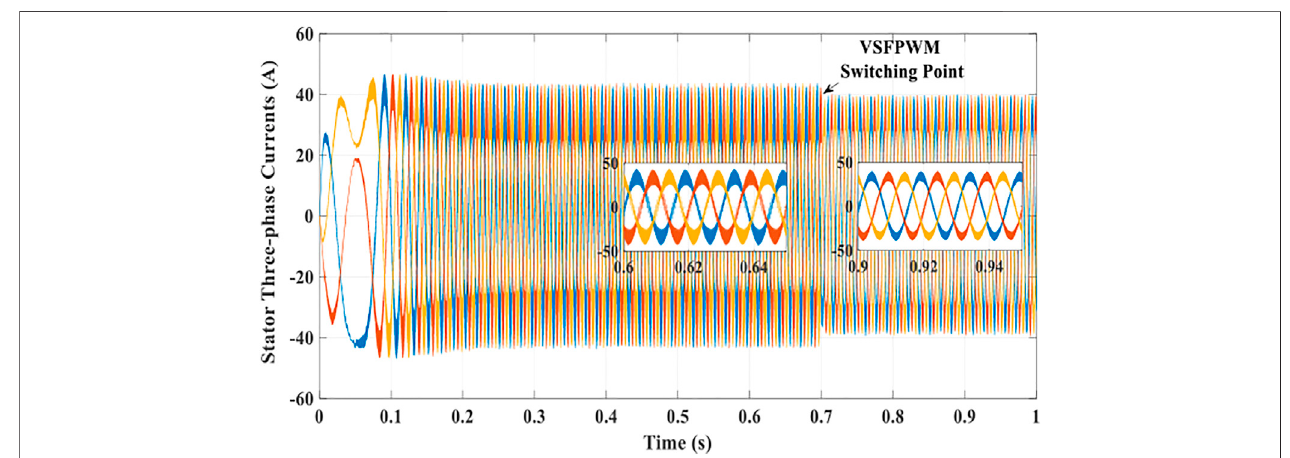
FIGURE 7 | Responses of